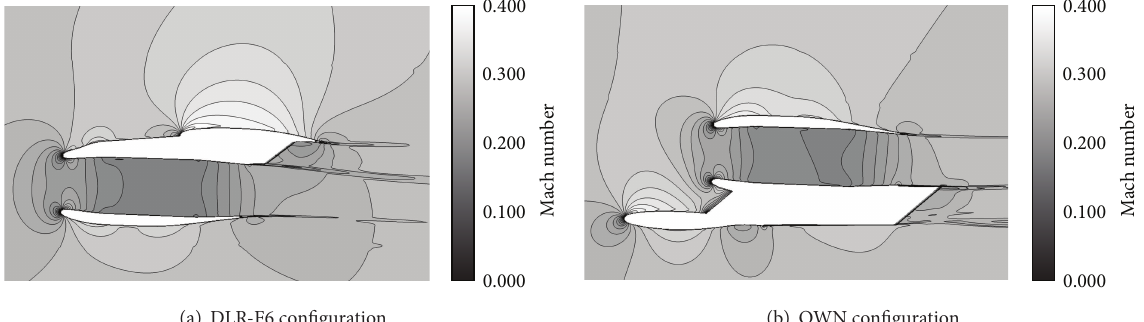
Figure 15: Mach number distributions at the nacelle center.